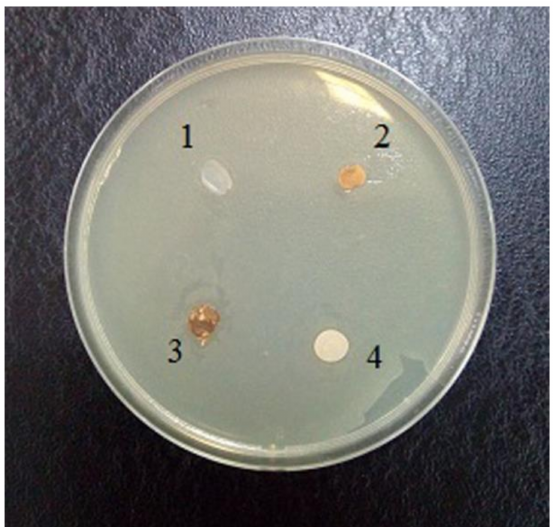
Figure 8. Evaluation of the antimicrobial activity of films with respect to Escherichia coli : 1 composite film (95% cellulose + 5% betulin), 2 filter paper, saturated with mycelium extract of Laetiporus sulphureus strain, 3 bacterial cellulose film, saturated with mycelium extract of L. sulphureus strain, 4 filter paper, wetted pyrogen-free water